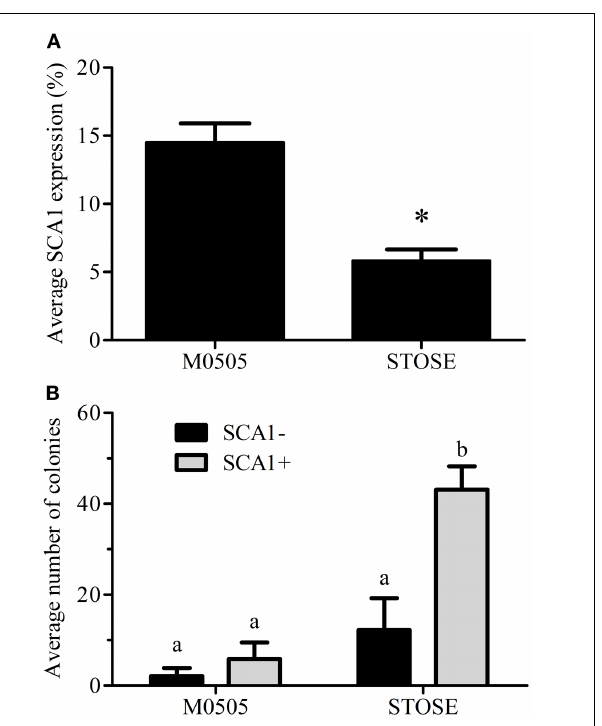
FIGURE 5 |A SCA1 + population is present in STOSE cells. (A) Percentage of SCA1 + cells in M0505 ( n = 6) and STOSE ( n = 11) cells as assessed by flow cytometry. * p < 0.01, Student’s t -test. (B) Quantification of colony formation in soft agar by SCA1 + and SCA1 − M0505 and STOSE cells. Colonies were counted using ImageJ software 7days after seeding 2.5 × 10 4 cells in soft agar.The average number of colonies in five fields of view is presented ( n = 3). ANOVA was used to determine significance; bars with different letters are significantly